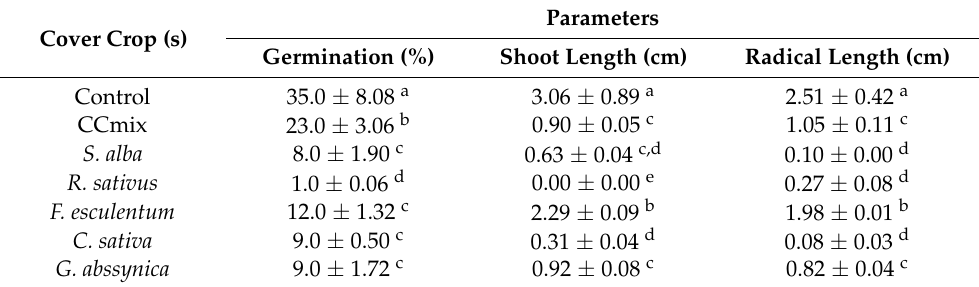
Table A2. The effects of different aqueous extracts on germination, shoot and radical length